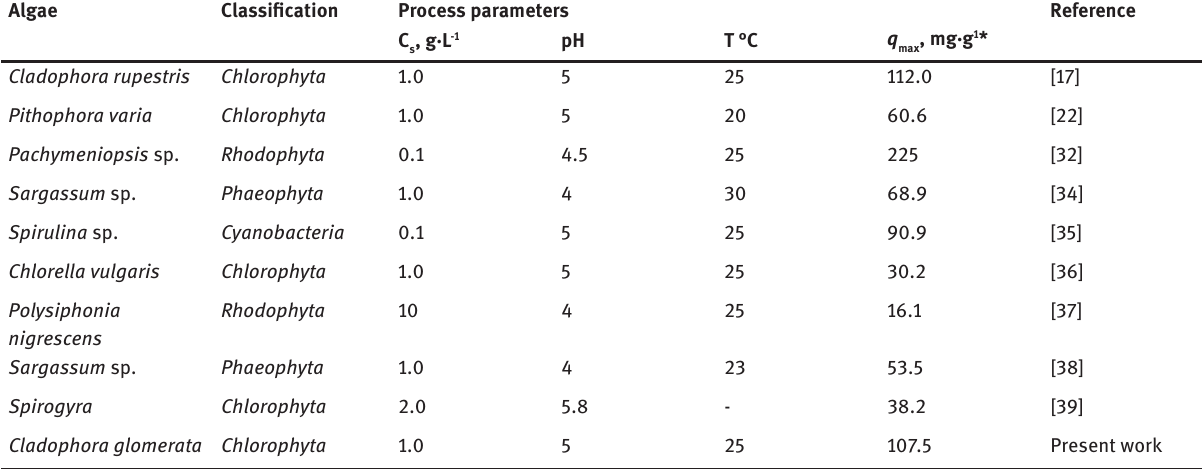
Table 3: The maximum biosorption capacity towards Cr(III) ions obtained for different algae. Algae